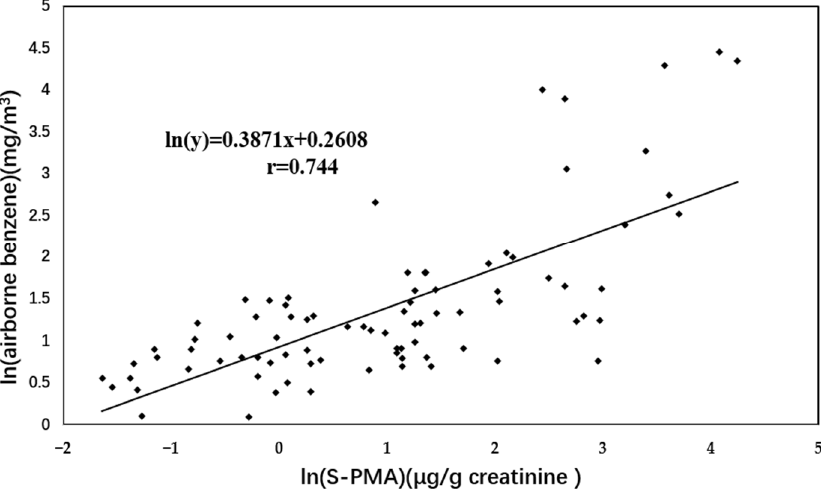
Figure 1. Correlation between natural logarithmic transformed benzene exposure levels (mg/m 3 ) and S-PMA values ( µ g/g